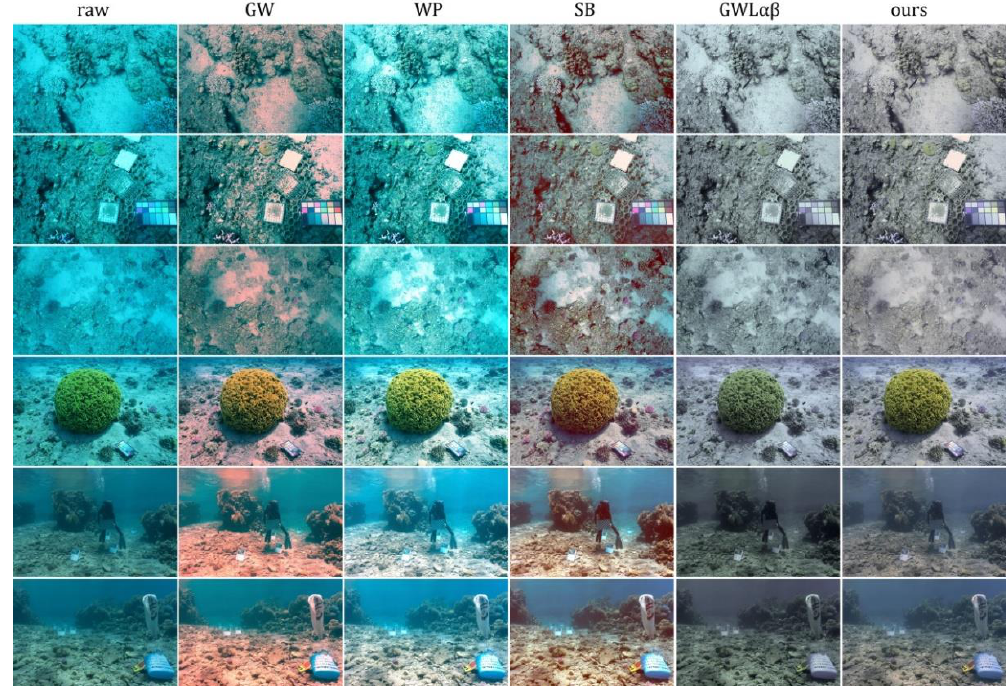
Figure 12. Comparisons on images in Sea-thru dataset [7]. From left to right are raw underwater images, the results of gray-world (GW) method, white-patch (WP) method, statistical-based (SB) method [21], Bianco’s (GWLαβ) method [37] and the proposed method.